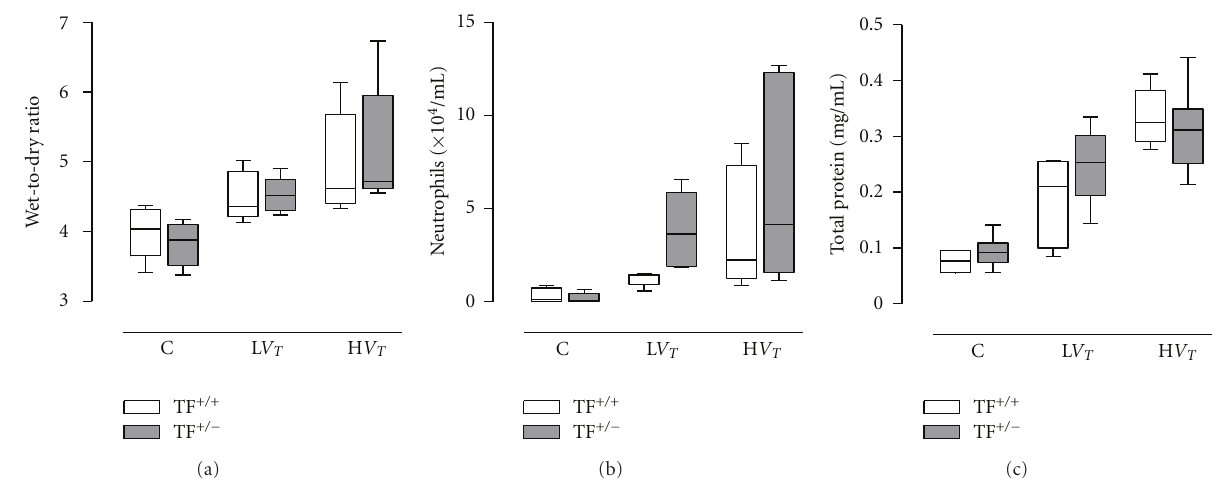
Figure 3: Wet-to-dry ratios, number of neutrophil cells, and total protein level in bronchoalveolar lavage fluid after 5 hours in control mice (C) and mice ventilated for 5 hours with lower tidal volumes (L V T ) or higher VT (H V T ). Each group consisted of heterozygote TF knockout mice (TF + / − ) and their wild-type littermates (TF + / + ). Data represent medians and interquartile range of six mice. Di ff erences between TF + / − and TF + / + are not statistically significant.